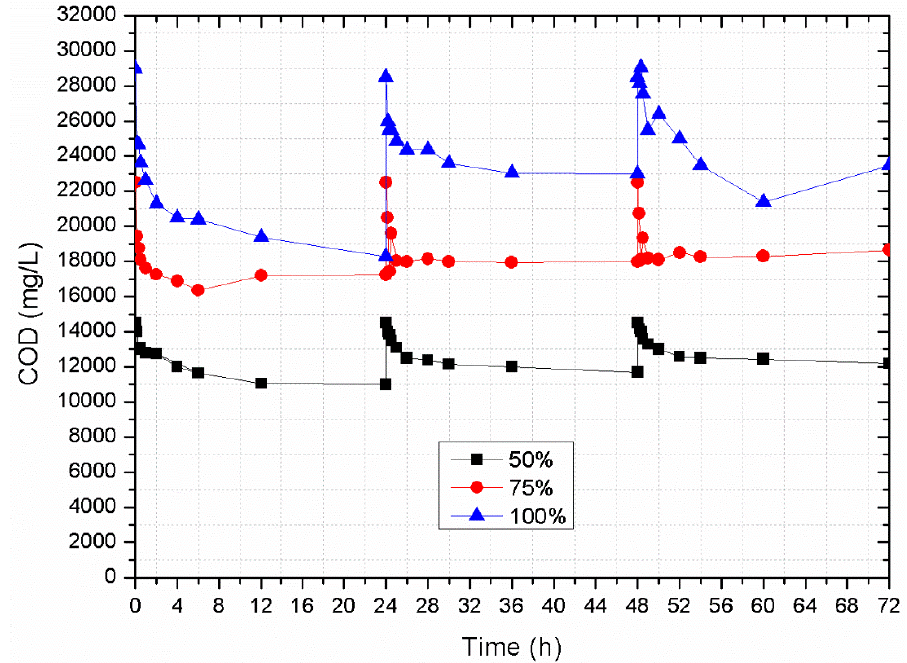
Figure 6. Effect of contact time on chemical oxygen demand (COD) removal by natural zeolite, granulometry 4.0–5.0 mm in column experiments using second cheese whey (SCW) at different dilution granulometry 4.0 – 5.0 mm in column experiments using second cheese whey (SCW) at different rates (100%, 75%, and dilution rates (100%, 75%, and 50%).